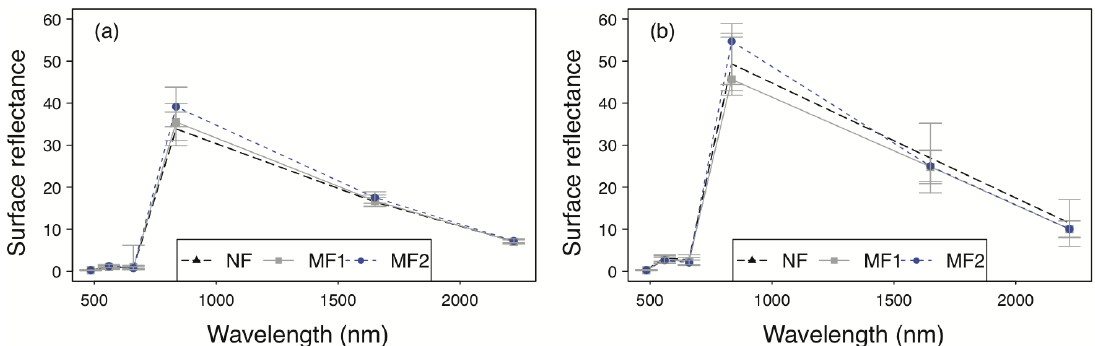
Figure 4. Landsat surface reflectance based on the location of field data ( a ) before and ( b ) after topographic